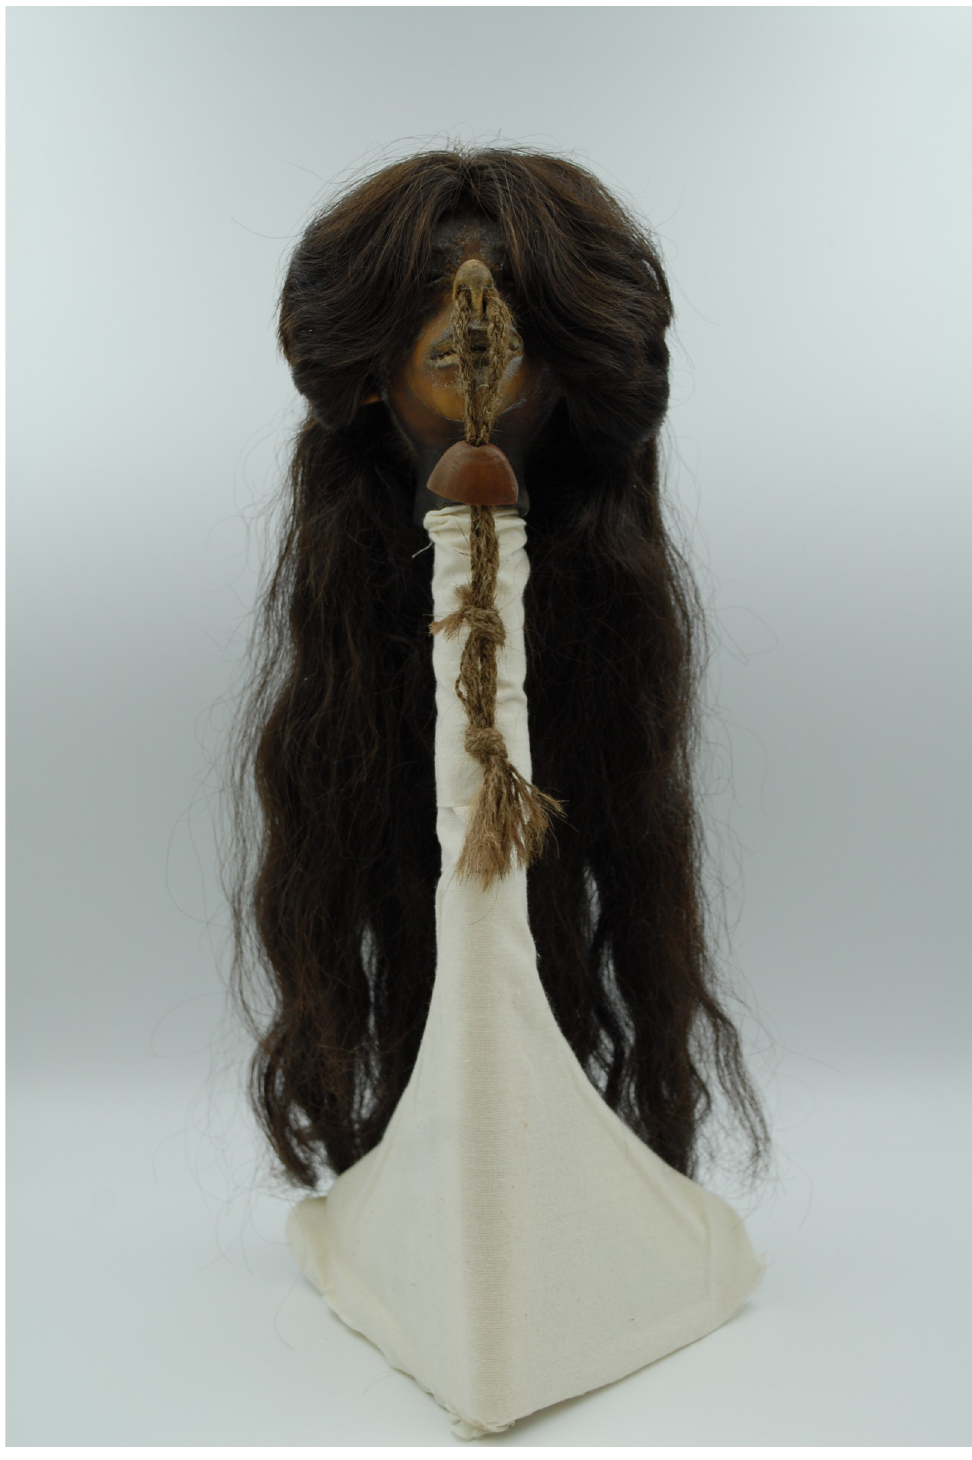
Fig 1. The Chatham tsantsa